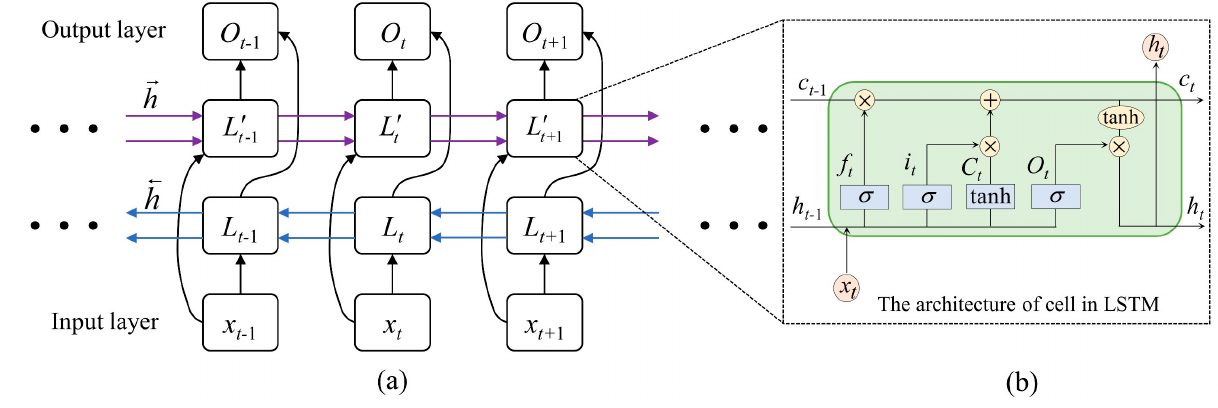
Figure 5. The basic structure of the Bi